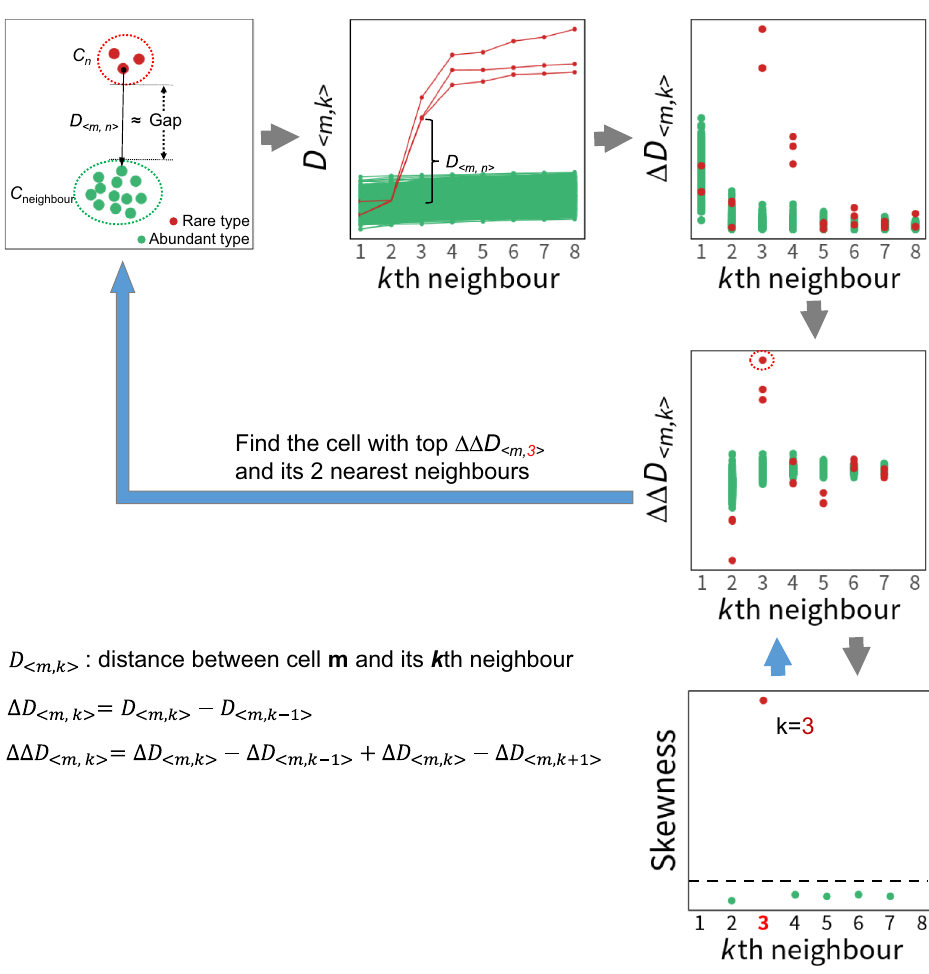
Fig. 1 Overview of GapClust. The fi rst step is obtaining K nearest neighbours for all cells. For each cell m , Δ D <m, k> and ΔΔ D <m, k> can be obtained according to the formula. Then the skewness of adjusted ΔΔ D <m, k> values is calculated. Candidate k can be identi fi ed if skewness > 2. In the last step, for each candidate k , the cell with largest ΔΔ D <m, k> value among N cells and its k -1 nearest neighbours are identi fi ed and subject to fi ltering steps to determine the fi nal rare cell